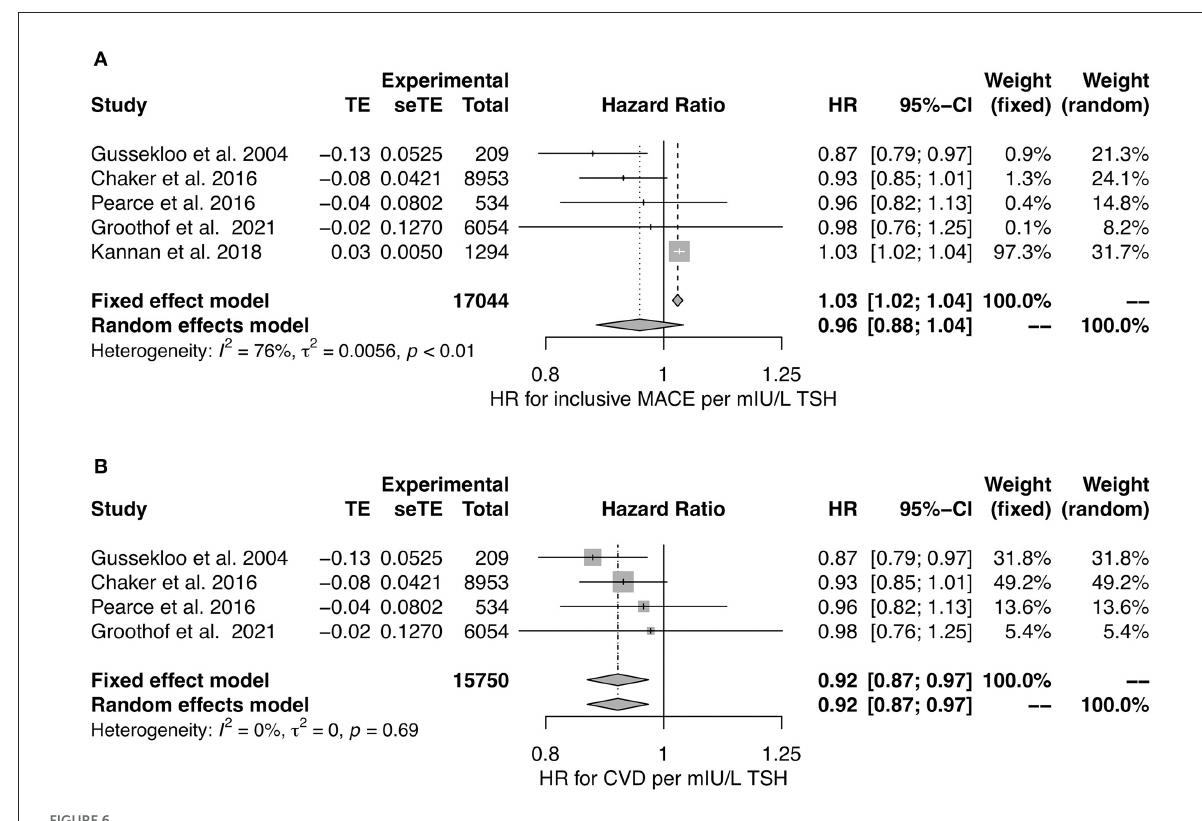
cardiovascular mortality. This study had a comparably small sample size of 643 elderly subjects